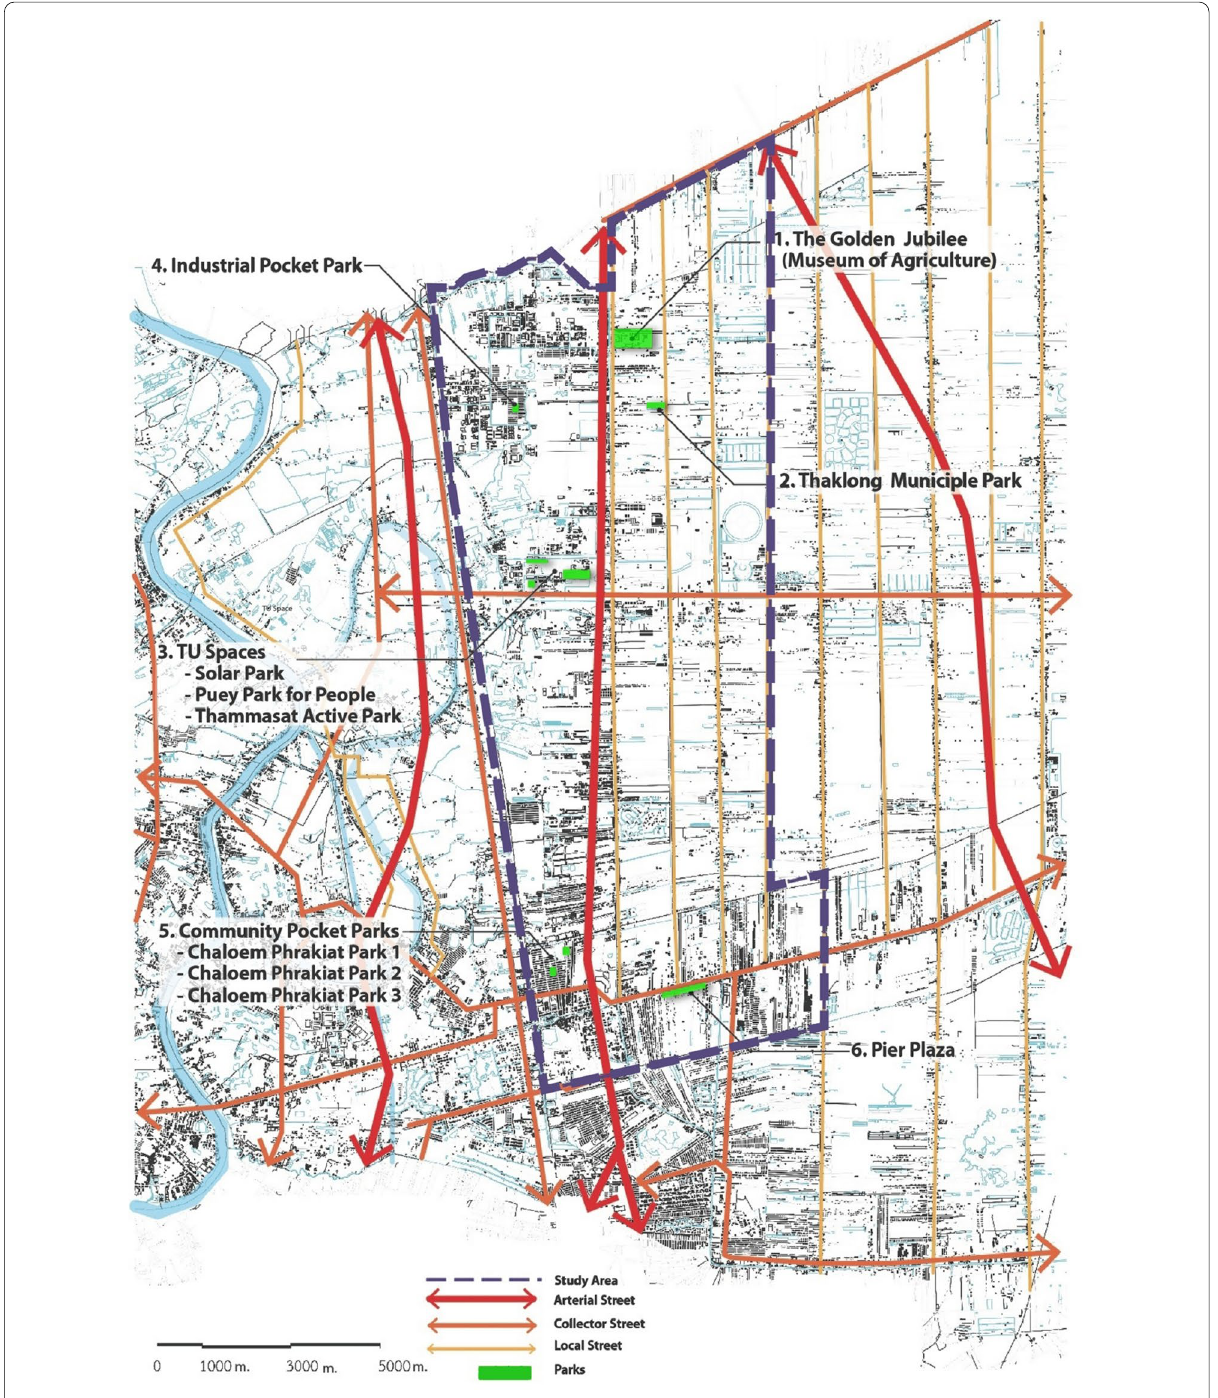
Fig. 6 Mapping of existing parks in Thaklong–Klongluang. (Adapted from Google Map